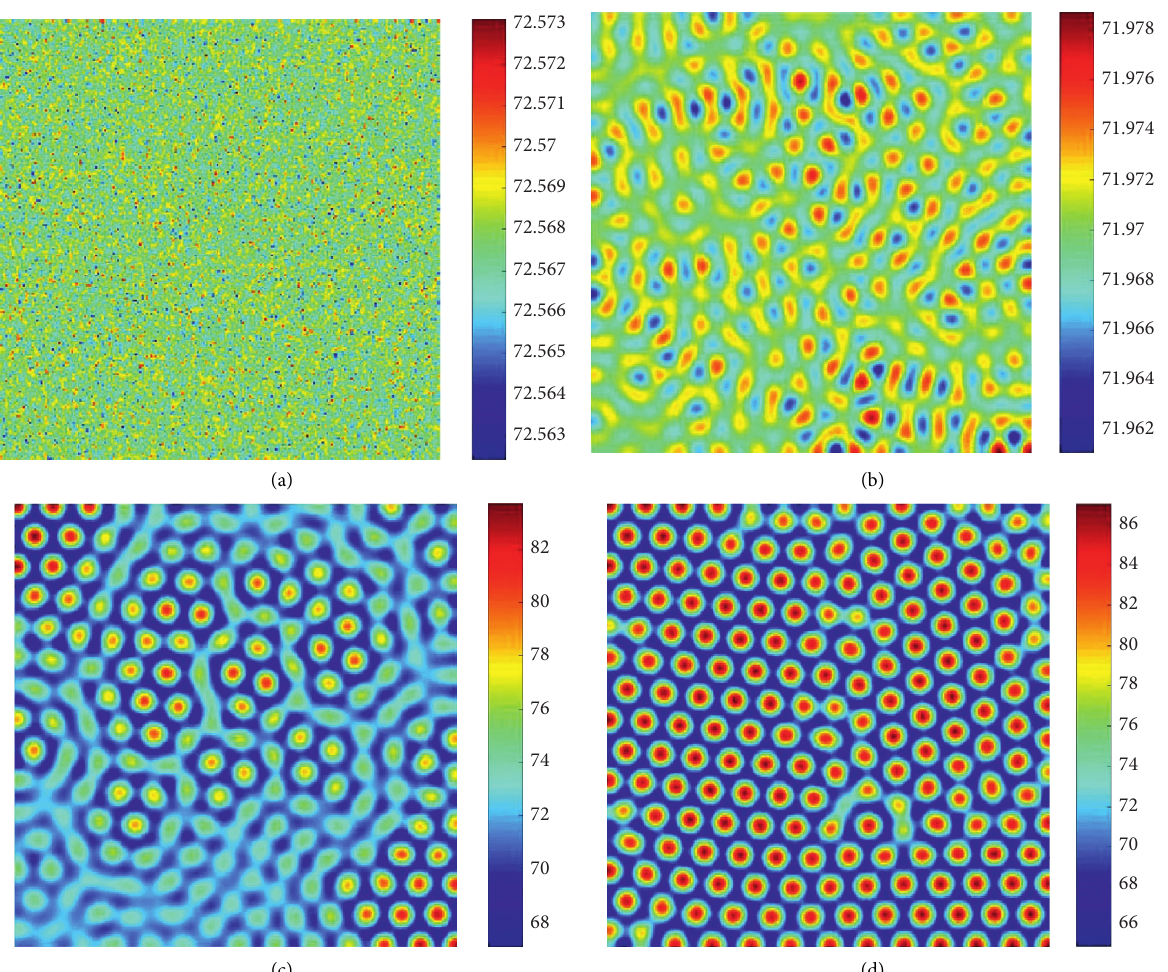
Figure 5: The iterations of stripe patterns of the predator with 31 � 1.009. The number of iterations is (a) 0, (b) 3600, (c) 130000, and (d)